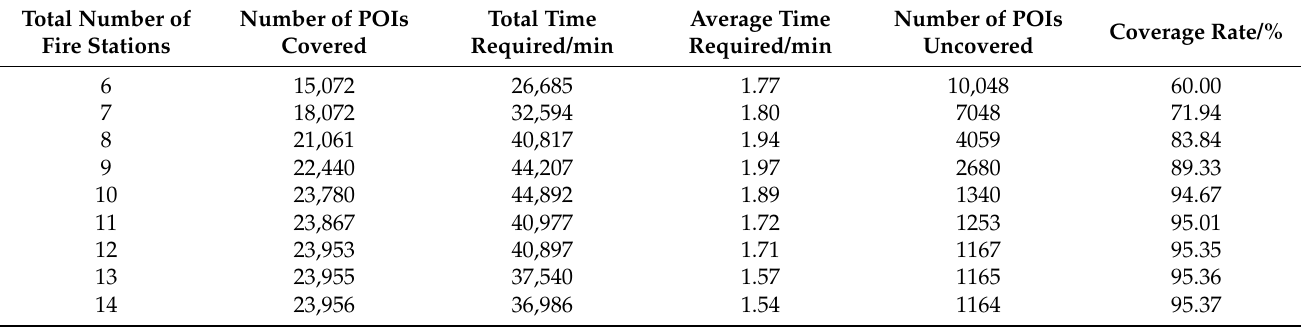
Figure 3. Location and maximum coverage for different numbers of fire stations. ( a ) Seven fire stations. ( b ) Eight fire stations. ( c ) Nine fire stations. ( d ) Ten fire stations. ( e ) Eleven fire stations. ( f ) Twelve fire stations. ( g ) Thirteen fire stations. ( h ) Fourteen fire stations. (The lines with different colors in represent the POIs assigned to different fire stations) Table 3. POI coverage rates for different numbers of fire